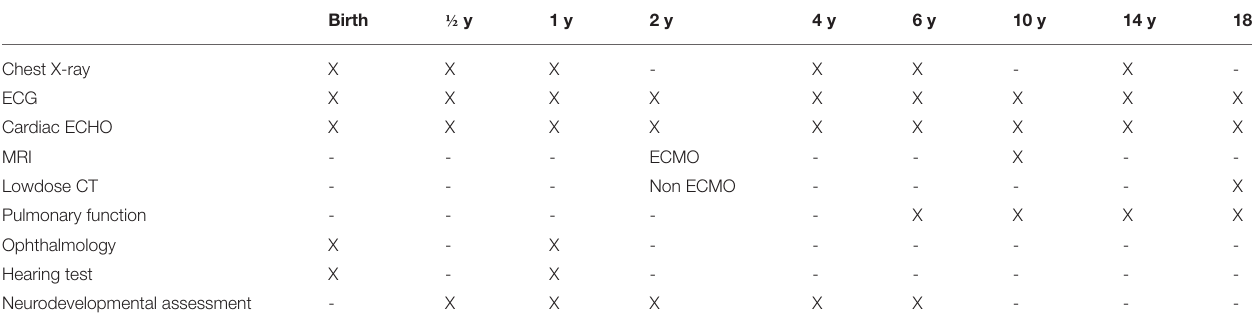
TABLE 1 | Schedule of our standardized follow-up program.